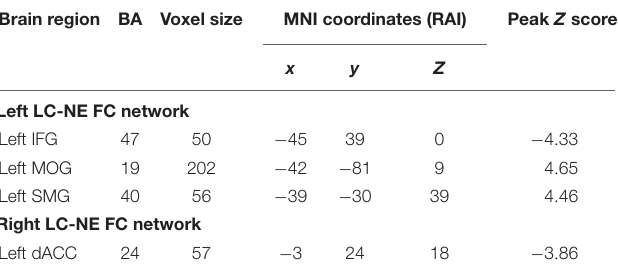
FIGURE 2 | Gender differences of LC-NE functional network in patients with CID was located in AMG (A) and MFG (B) . The blue color bar means the LC-NE FC in female is lower than that in male. AMG, amygdala; MFG, middle frontal